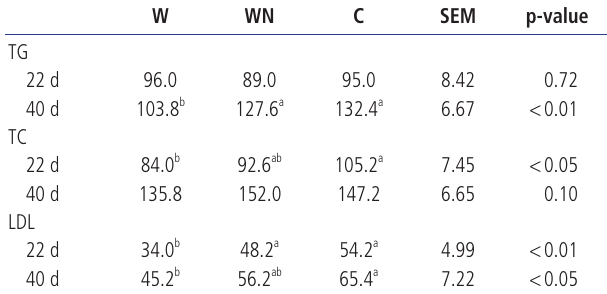
pared to that of the W diet, and the RL of jejunum was lower (p<0.05) for birds fed the C diet than for birds fed the W diet with those fed the WN diet being intermediate. The C and WN diets showed a decreased (p<0.01) RL of cecum compared to that of the W diet.